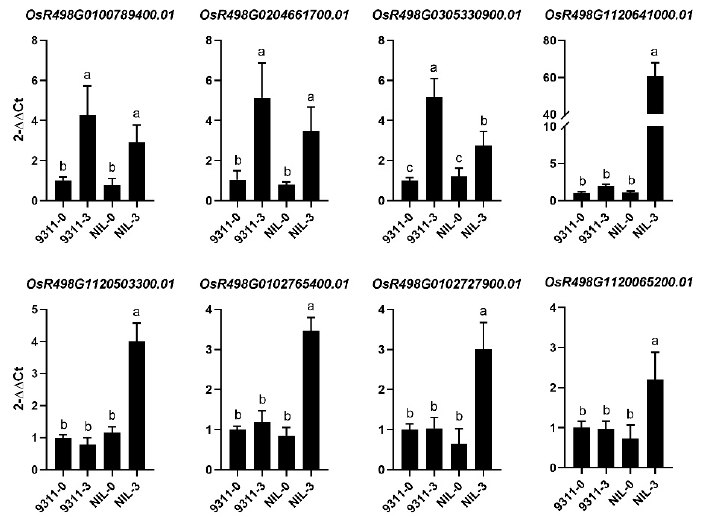
Figure 5. Quantitative real-time PCR (qRT-PCR) validation of the selected DEGs in 9311 and NIL- Bph43 -9311. OsAct1 was used as an internal control. The relative expression levels of each gene were measured using the 2 −ΔΔ CT method. Data represent the means (three biologically independent experiments for gene expression) ± SEM. Different letters above the bars indicate significant differences ( p < 0.05).